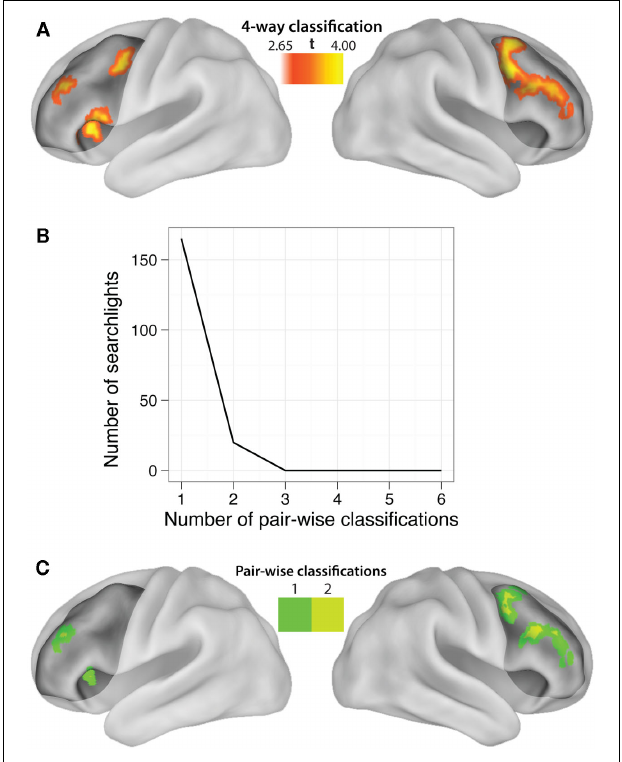
FIGURE 4 | Localization of LPFC practiced-to-novel decision rule transfer. (A) Searchlight MVPA of decision rule four-way classifications ( practiced → novel , whole block) within LPFC.The highlighted locations are clusters of “searchlights” (spheres with 9.6mm radii) that consistently decoded which decision rule individuals were using. See Table 5 for a list of significant clusters. (B) Most of the searchlights were only able to decode a single pair-wise comparison, with two pair-wise comparisons as the maximum decoded by any single searchlight.This demonstrates an advantage of using MVPA with anatomical ROIs rather than searchlights, and suggests the Figure 2C result is due to spatially variable or distributed coding of rules within LPFC. (C) Localization of the pair-wise results, restricted to the significant four-way classification searchlights to correct for multiple